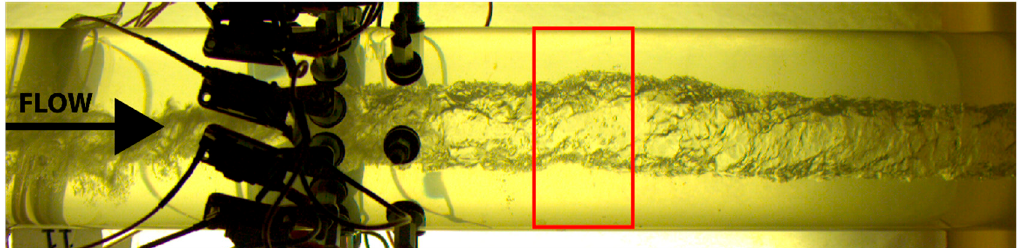
Figure 9. Original Image (2040 × 500 px) and box considered during the image processing and core size calculation. The obtained image after the cropping has a size of 200 × 400 px. The image corresponds to the 26th frame of the experimental set 11.